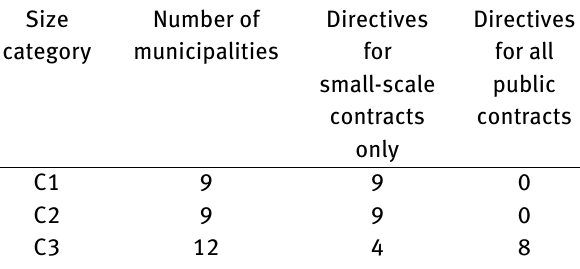
Table 5: Characteristics of the data